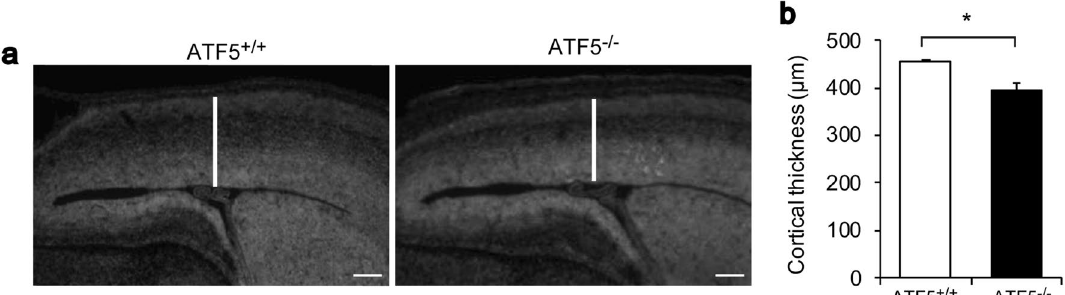
Figure 1. The reduced cortical thickness in the developing cortices of ATF5 −/− mice. ( a ) Cortical sections obtained on embryonic day 15 (E15) were stained with Hoechst 33342 to label the nuclei prior to an analysis of cortical thickness (solid line). ( b ) Quantification of the cortical thickness. Data are presented as mean ± S.E.M. ( n = 3 mice per group, * p < 0.05; Student’s t-test). Scale bars represent 100